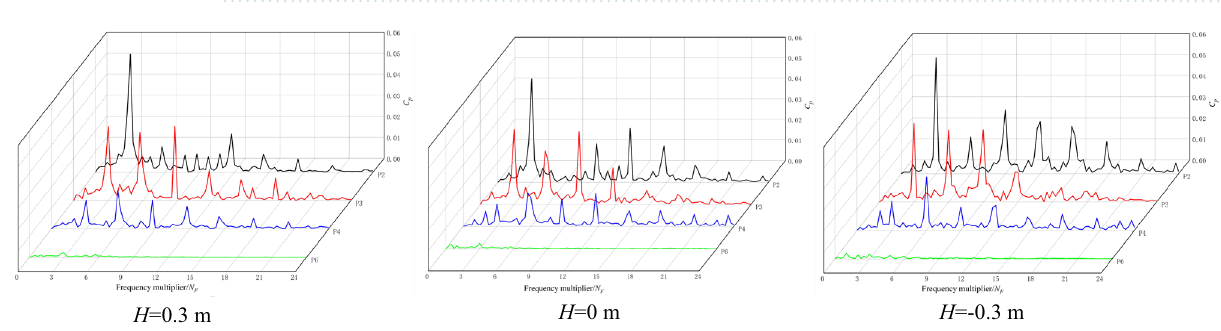
Figure 9. Time-domain diagram of pressure fluctuation under the NZHC.